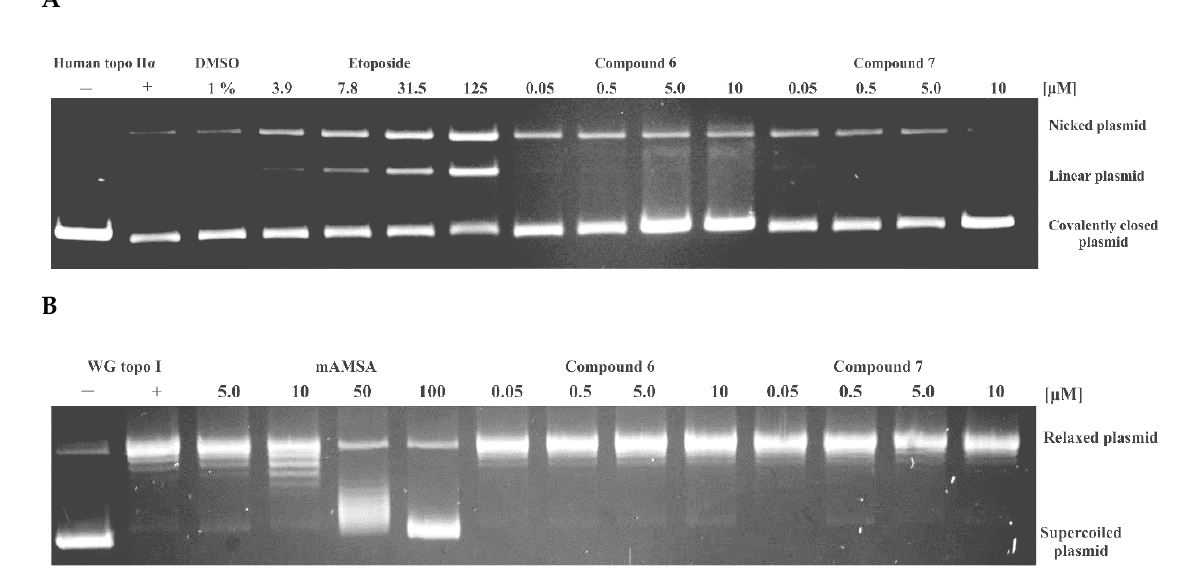
Figure 5. ( A ) Human topo II α cleavage assay. The assay was performed at four different concentrations of compounds 6 and 7 (0.05, 0.5, 5.0, and 10 µ M), and etoposide was used as a positive control (3.9, 7.8, 31.5, and 125 µ M). ( B ) Unwinding assay. The assay was performed at four different concentrations of compounds 6 and 7 (0.05, 0.5, 5.0, and 10 µ M), and of the positive control intercalator mAMSA (5.0, 10, 50, and 100 µ M).